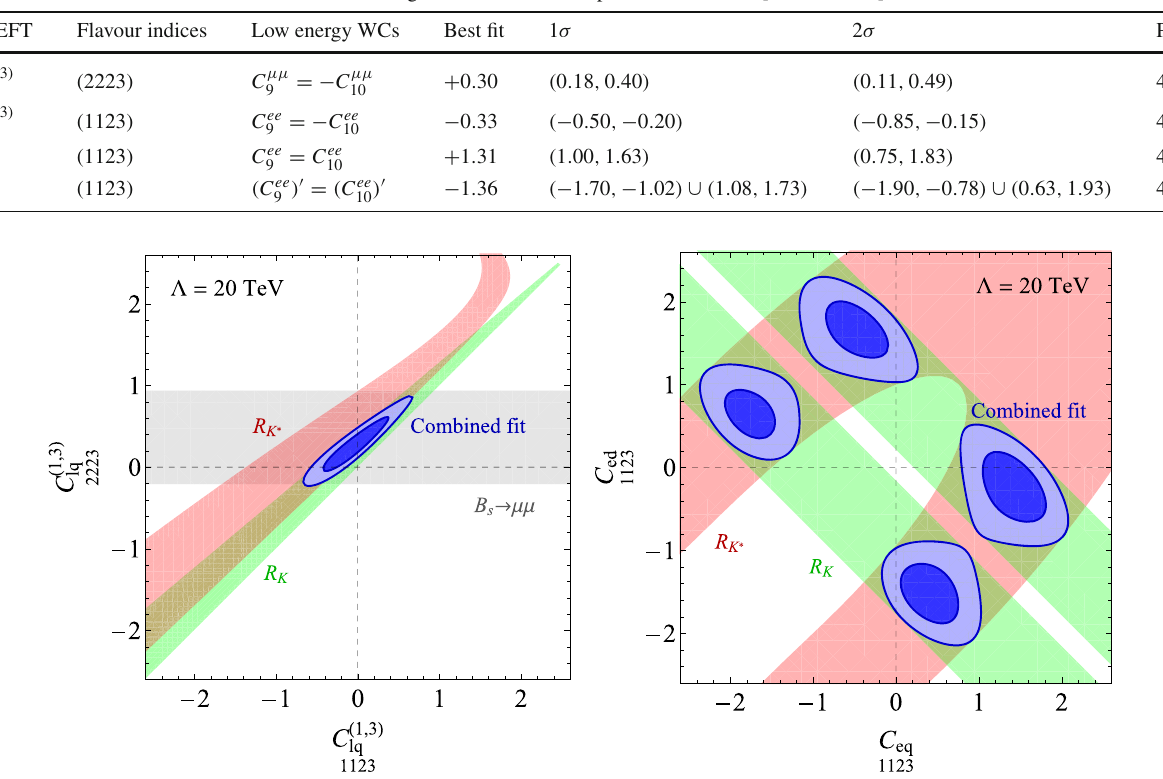
Fig. 1 Constraints on the left-handed WCs C ( 1 , 3 ) coupled to electrons racy of R K (green), R K ∗ (red) and B s → μμ (gray) by assuming lq (cid:3) = 20 TeV. The combined fit of this data is shown by the dark (light) and muons (left panel), and the WCs containing right-handed lepton currents, C eq and C ed , coupled to electrons (right panel). The allowed blue regions at 1 σ ( 2 regions are derived from the experimental measurements to 2 σ accu-